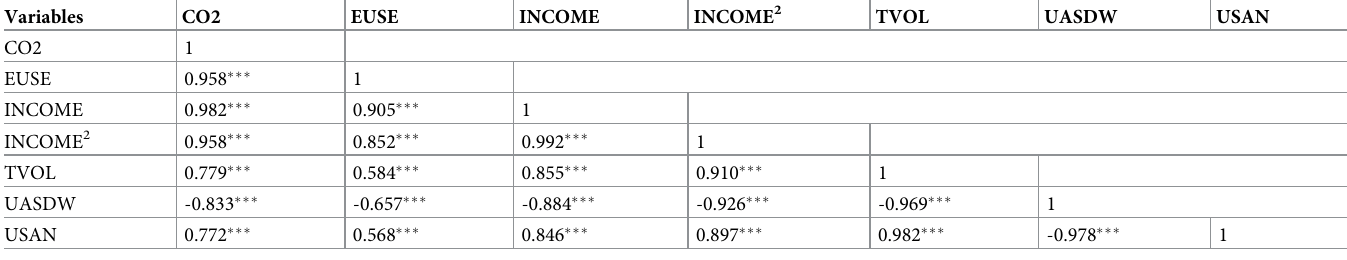
Table 3. Correlation